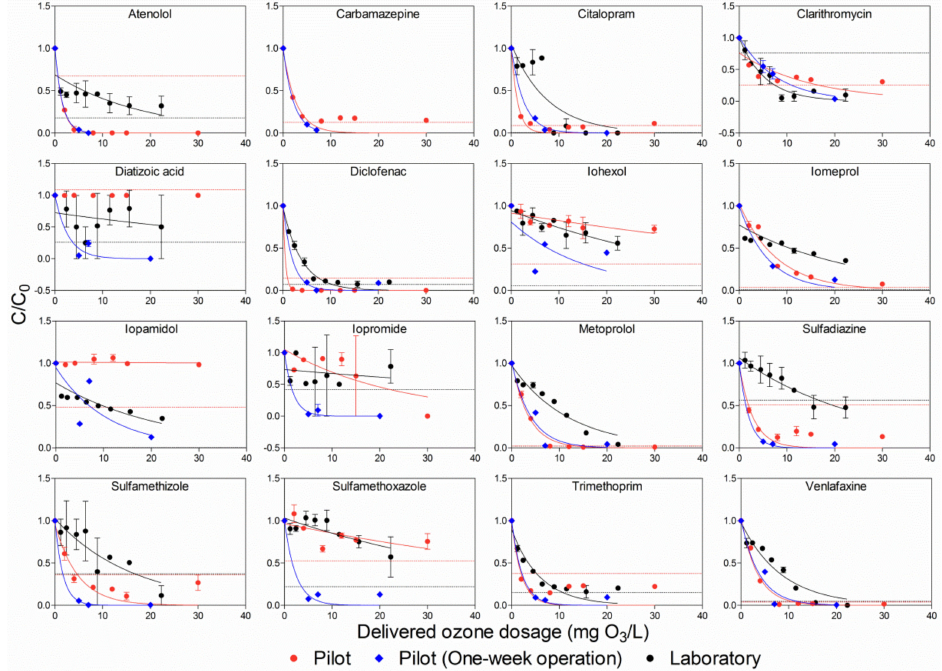
Figure 2. Comparison of pharmaceutical removal by ozone in the e ffl uent of the pilot hybrid system. The dashed lines in the Figure stand for LOQ of the pharmaceuticals. The same dashed line (red) was applied for both the pilot and the pilot (one-week operation) experiments. Error bars represent standard